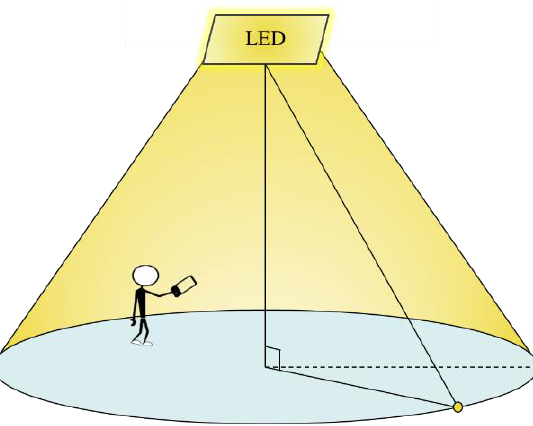
Figure 6. LP-VLP system fuzzy locates the coverage area of a flat lamp.